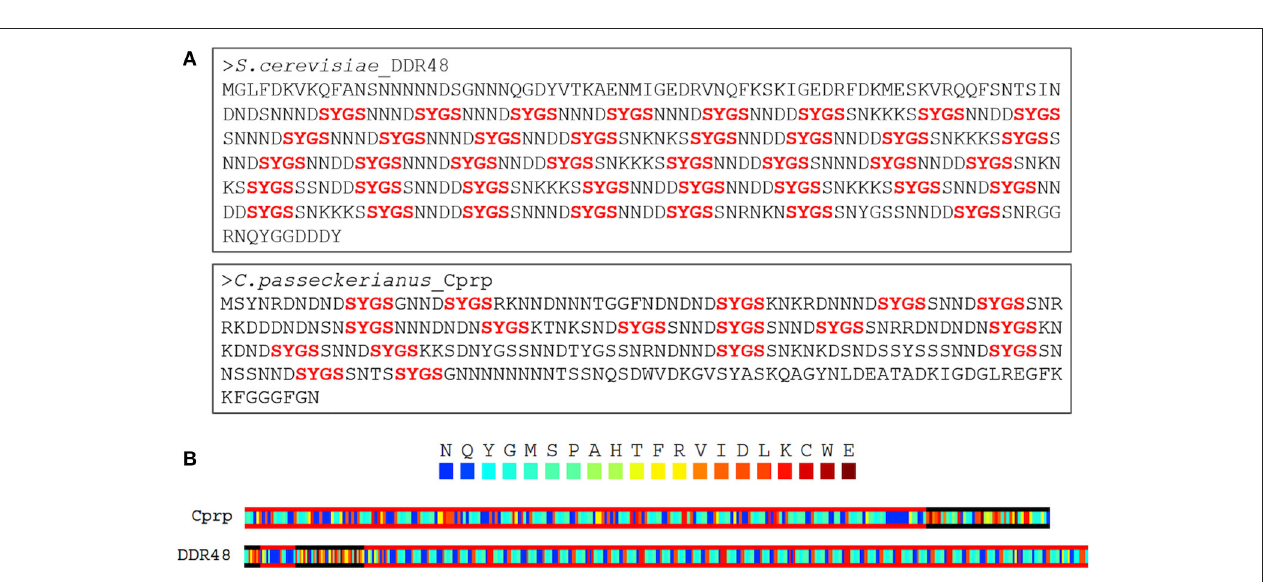
FIGURE 2 | (A) Both DDR48 and Cprp are shown to be highly repetitive proteins with low amino acid sequence complexity, being enriched in asparagine, serine, aspartic acid, and glycine residues. Both contain multiple [G/S]-Y-[G/S] motifs (in red), which are known to be present in intrinsically disordered RNA-binding proteins. (B) A PLAAC analysis of Cprp and DDR48 showing regions (framed in red) which are predicted to be prion-like domains ( Lancaster et al., 2014). strain Y16758. In addition, pYES2-19 (lacking any insert)